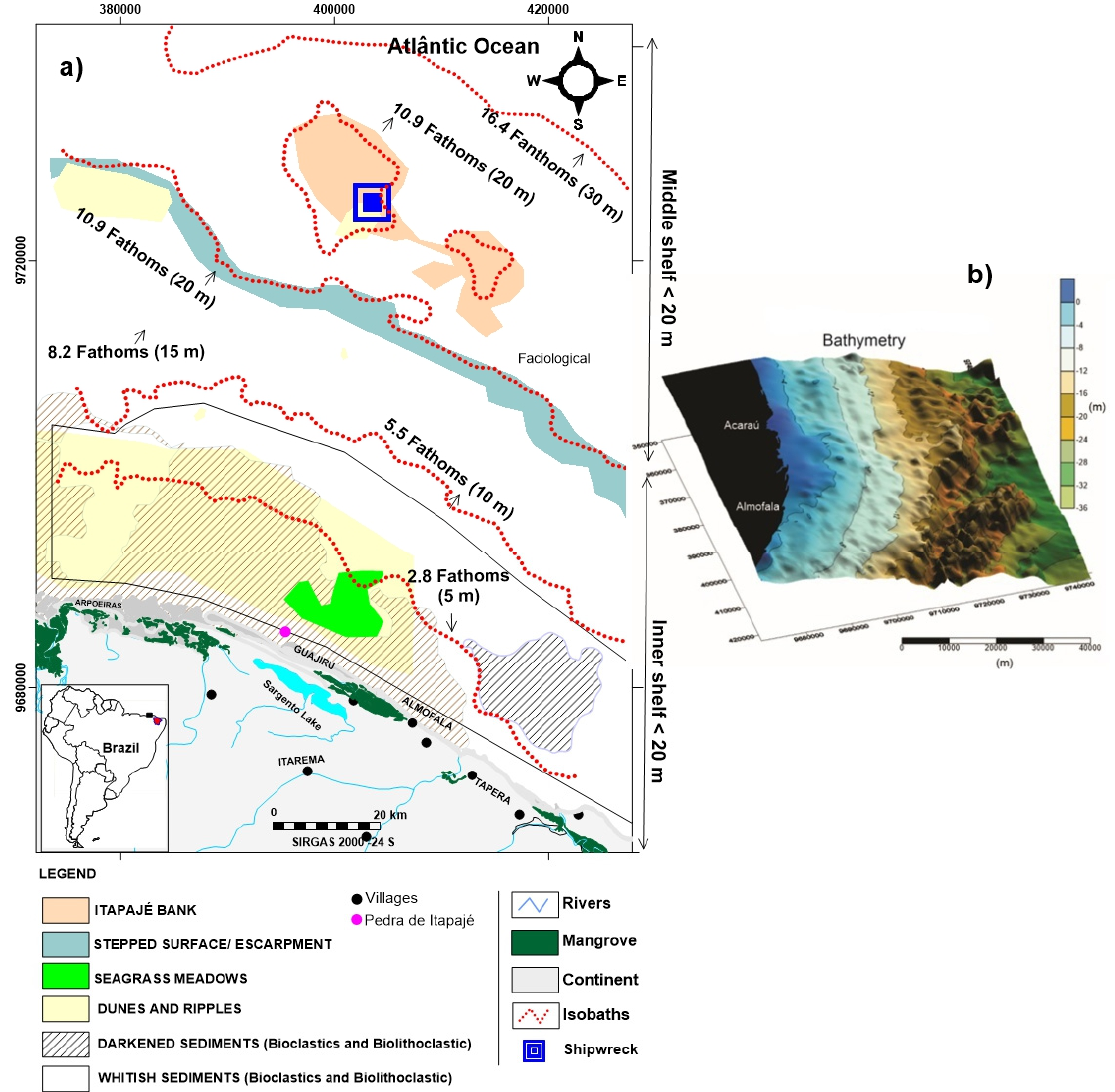
Figure 2. ( a ) Basemap of sedimentary facies/main features) and ( b ) Bathymetry. Source: [29,35,37,40,45] and Brazilian Navy and